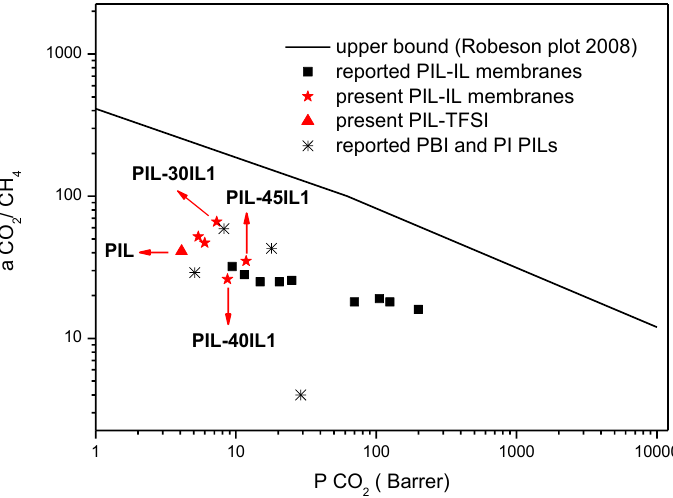
Figure 10. CO 2 /CH 4 separation performance of the prepared membranes. Data are plotted on a log-log scale and the upper bound line is adapted from the respective Robeson plot [20]. Literature data reported for other PIL-IL composite membranes ( (cid:4) ) [30,60–62] and PIL membranes (